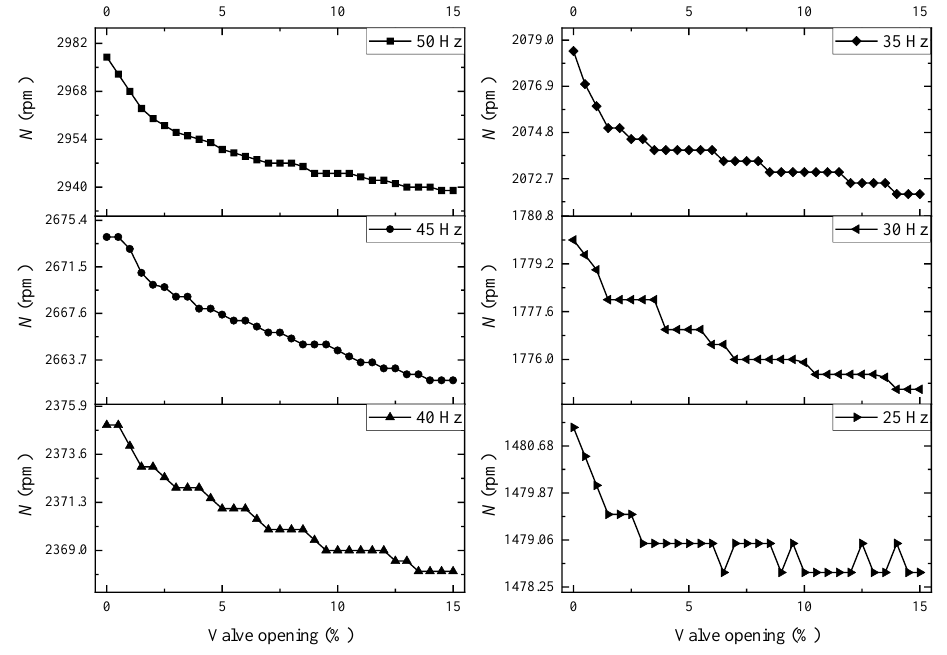
Figure 5. Speed varies with valve opening.